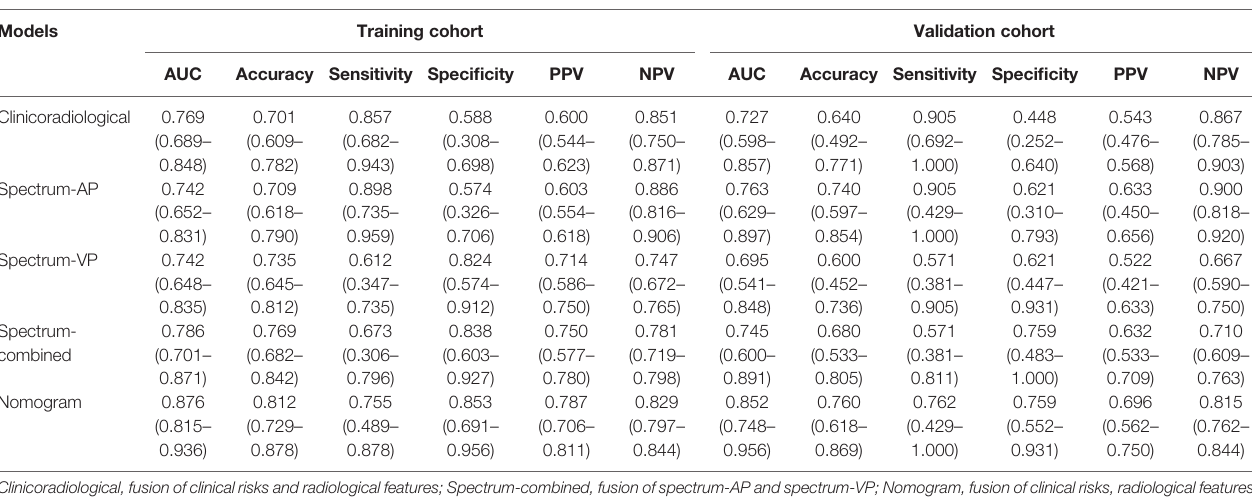
clinicoradiological and single spectrum-combined models.